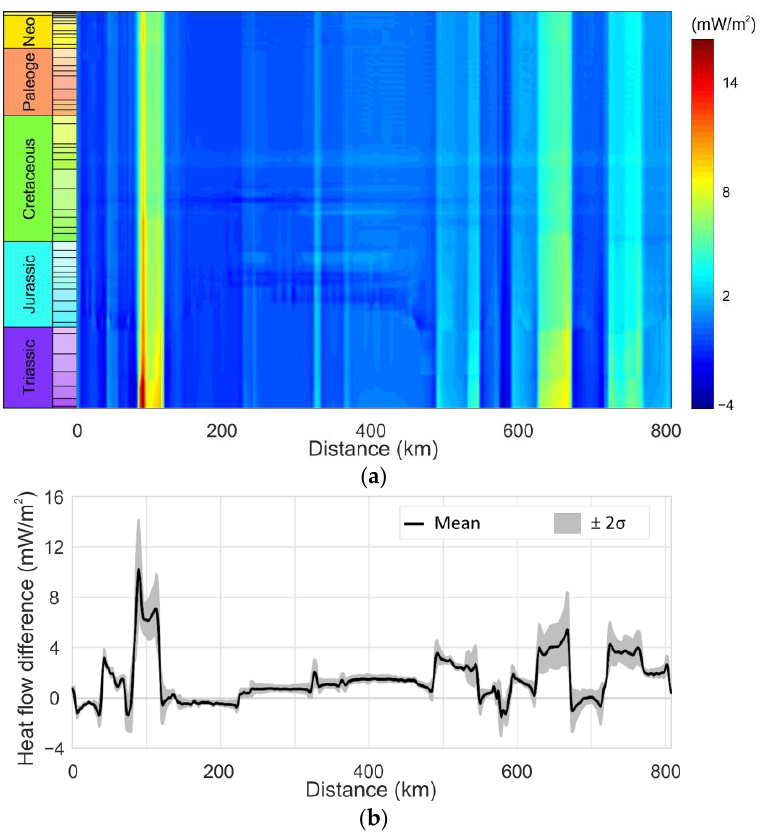
Figure 10. ( a ) Difference in spatio-temporal variations of calculated basal heat flow between Model 1 and Model 2 (values of plot = values of Model 1 − values of Model 2) as a function of distance from the west end of the profile; ( b ) mean value of the basal heat flow difference, where ±2σ denotes a two-standard-deviation interval around the mean value.